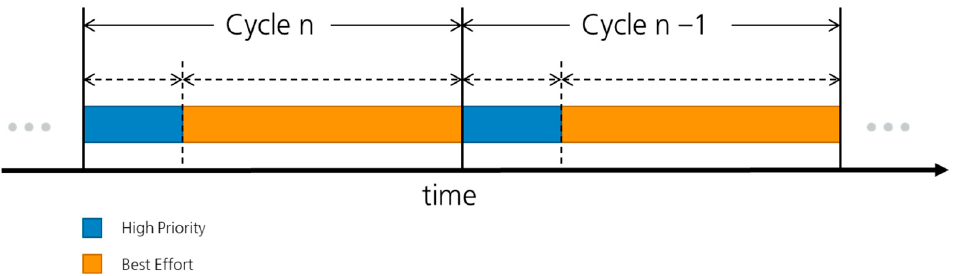
Figure 3. Examples of IEEE 802.1Qbv scheduled traffic with two time slots for high priority and best effort traffic.